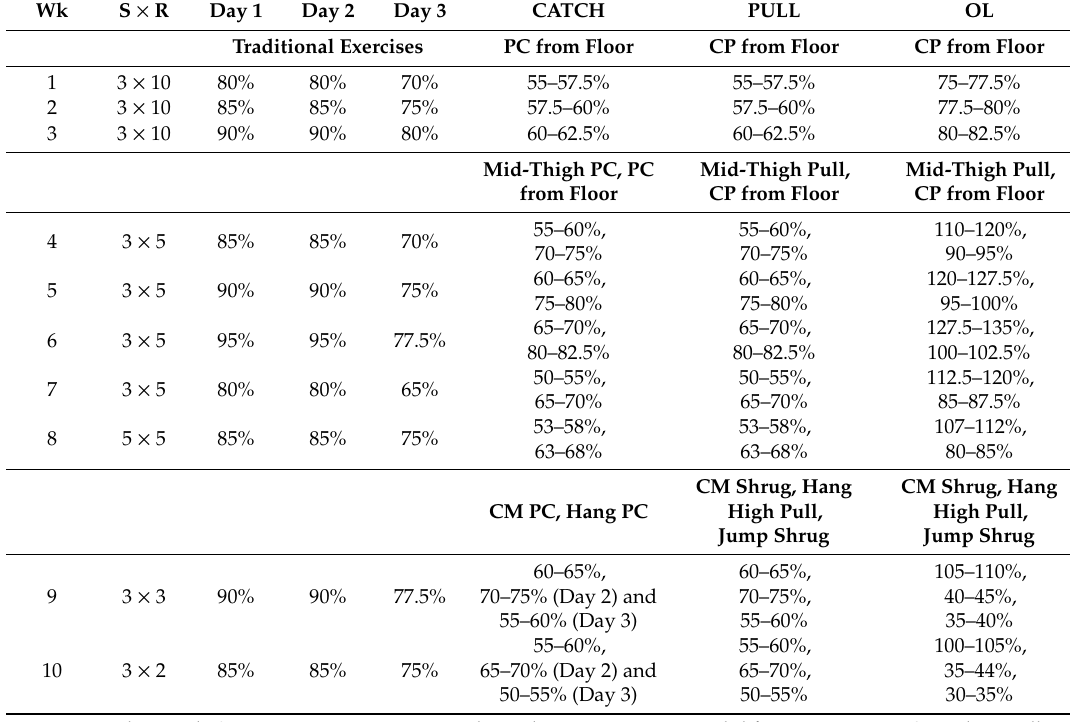
Table 3. Weekly relative intensity (set-repetition best) for traditional exercises and weightlifting derivative load (1RM power clean (PC) percent) progressions for the CATCH, PULL, and OL